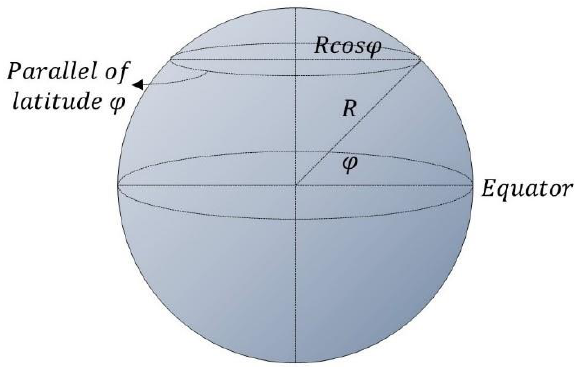
Figure 3. Spherical-shaped earth.